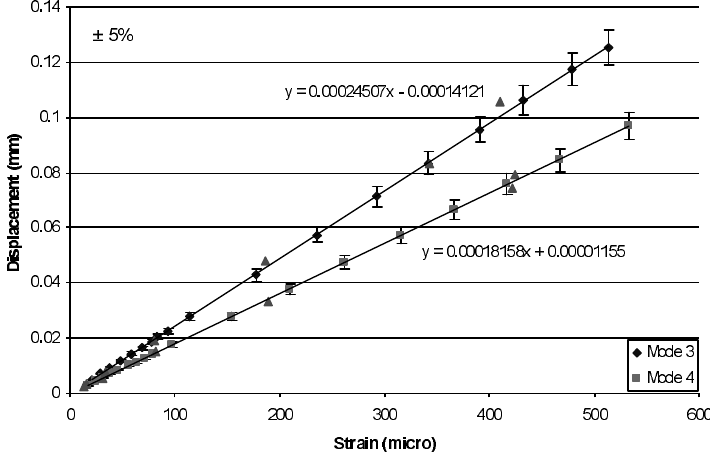
Fig. 6. Strain/Displacement relationship for plate